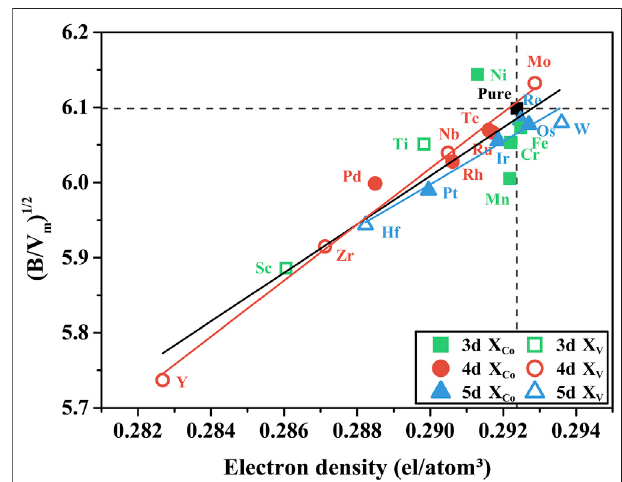
FIGURE5| Relationship between theelectron density and ( B / V m ) 1/2 of TM-substituted γ ′ -Co 3 (V, Ta). The units of B and V m are GPa and 10 − 6 m 3 / mol,